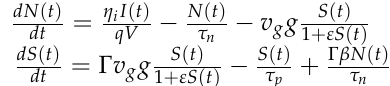
Figure 9. Gain versus carrier density curve fits for (001) and (110) crystal orientations in strain In- GaAs QW. Table 2. Parameters used in the simulation of VCSEL. Adapted with permission from [5]. Symbol